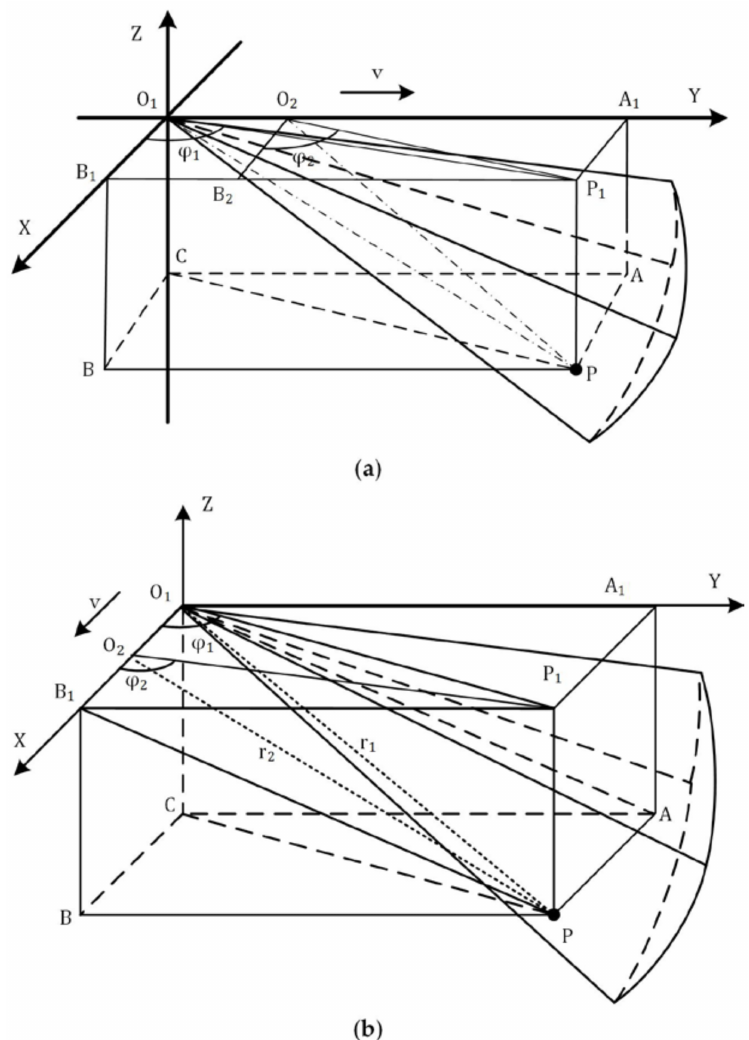
Figure 6. Two detection modes. ( a ) The Adaptive Resolution Imaging Sonar (ARIS) moves along the beam transmitting direction; ( b ) the moving direction of the sonar is perpendicular to the beam transmitting